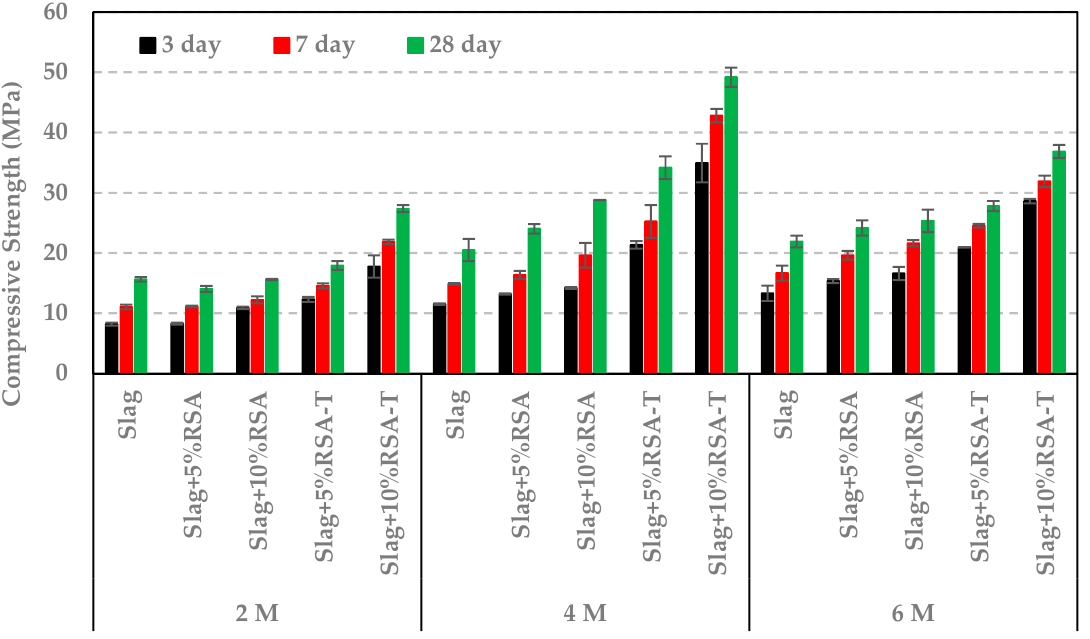
Figure 6. Compressive strength of mortar cubes at different activator concentrations. The performance of samples containing RSA and RSA-T were compared to those containing sodium silicate (Na-Si). Sodium Silicate was added at 12.5% and 20% replace- ment of 4 M NaOH solution to prepare activator solutions with SiO 2 /Na 2 O ratios of 0.29 and 0.58, respectively. The samples containing sodium silicate (Slag + 12.5% Na-Si and Slag + 20%Na-Si) had higher compressive strength that those containing RSA, as shown in Figure 7. However, sample containing 5%RSA-T showed a higher compressive strength than the sample prepared with 12.5%Na-Si. Compressive strength of Slag + 20%Na-Si was higher than Slag + 10%RSA-T. However, the compressive strength of samples containing 15%RSA-T was slightly higher than the one made with 20%Na-Si. Figure 7 also shows that sample containing 15%RSA had similar compressive strength to the one made with 12.5%Na-Si.